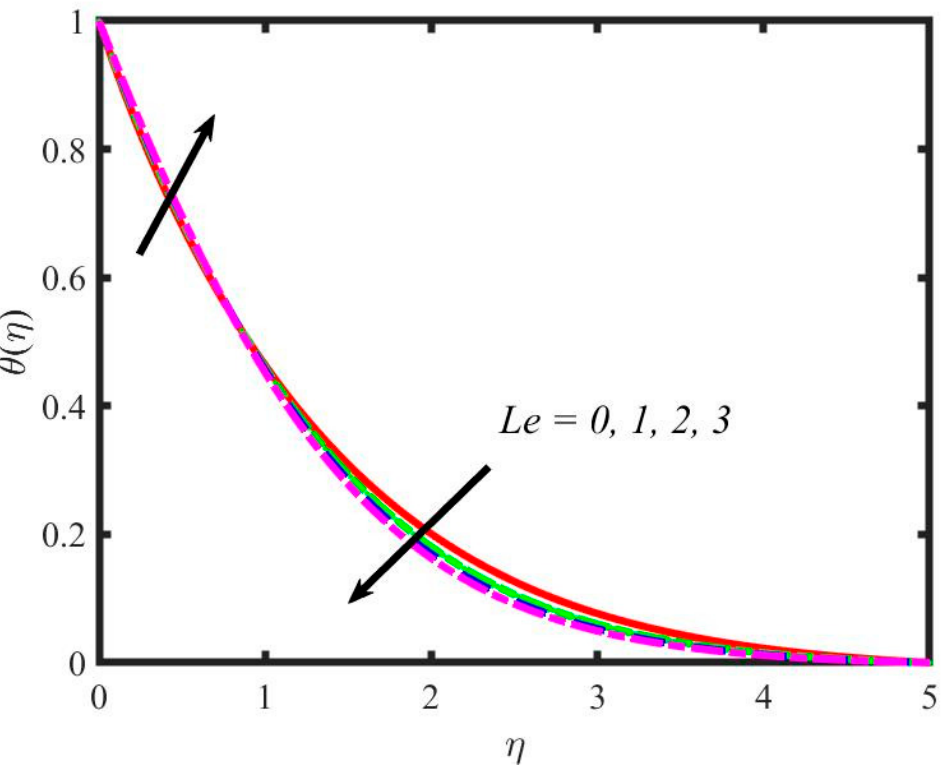
Figure 13. Variations in nanoparticle temperature for Lewis number.